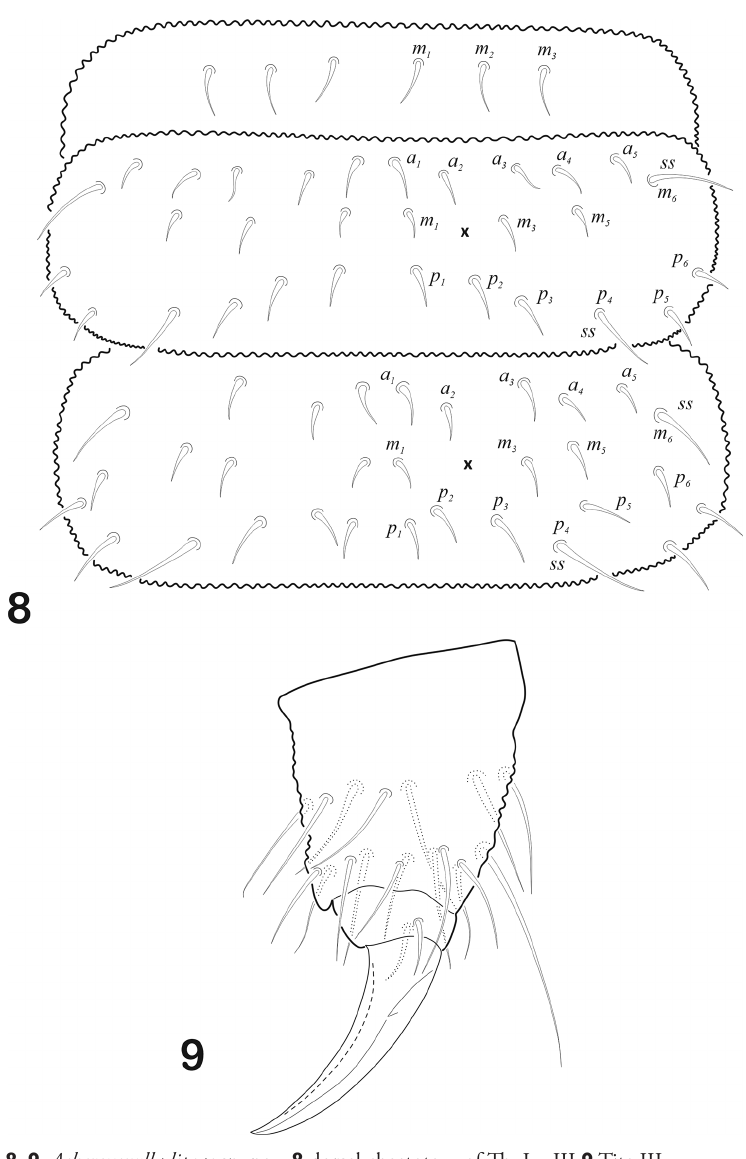
of supernumerary setae on left side of abdominal segment III was observed on one paratype, where there were 3 setae “p4”, giving the appearance of sensorial seta to be on position